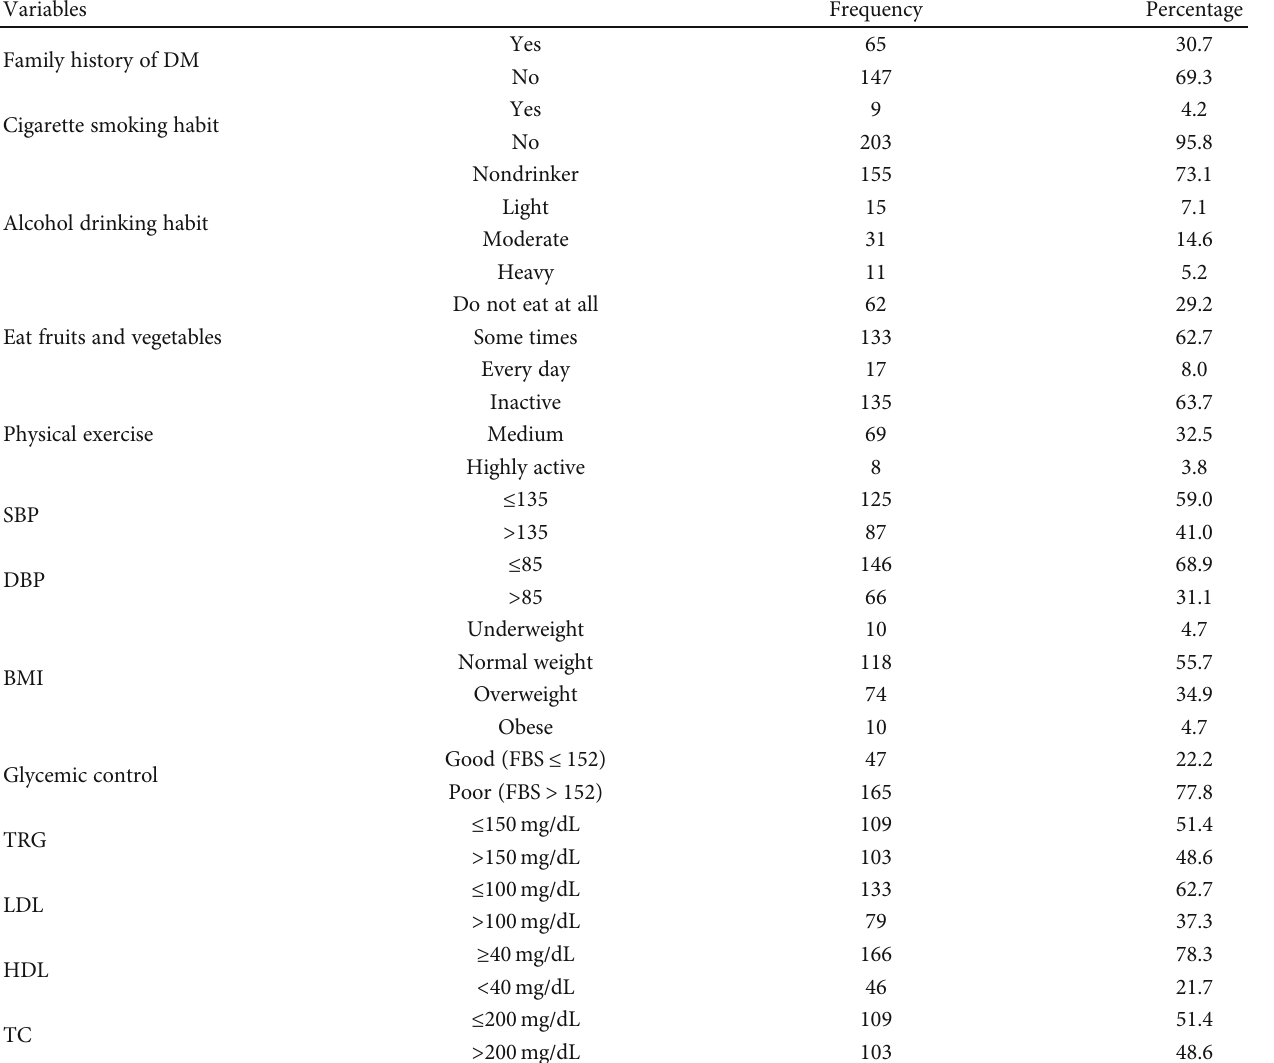
Table 1: Clinical data of DM patients attending at FHCRH, Bahir Dar, Northwest Ethiopia, 2019 ( n = 212 ). Variables